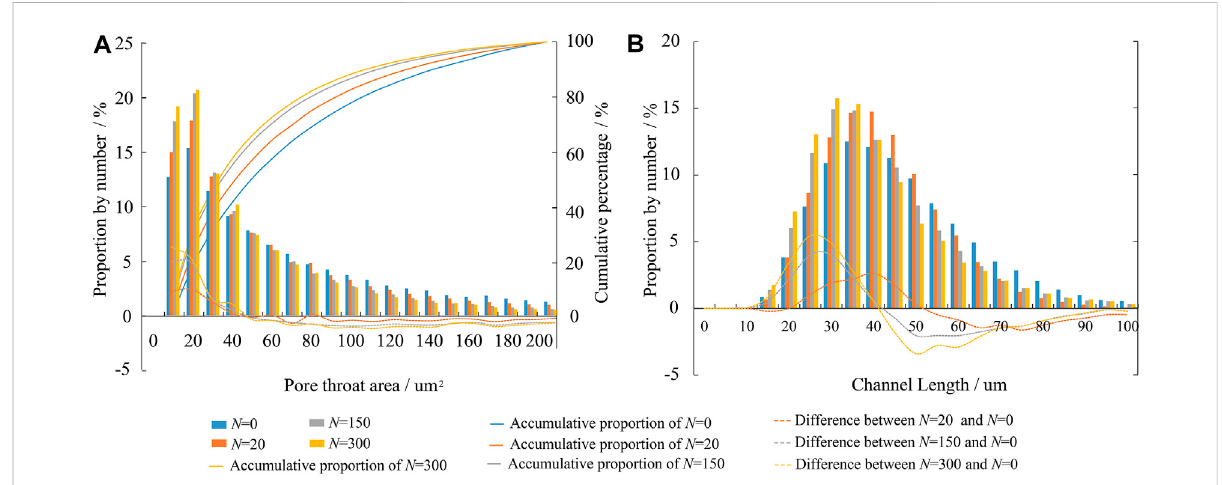
Pore-throatsizedistributions. (A) Pore-throatareadistributionsandthedifferencebeforeandafterloading. (B) Channellengthdistributionsand the difference before and after